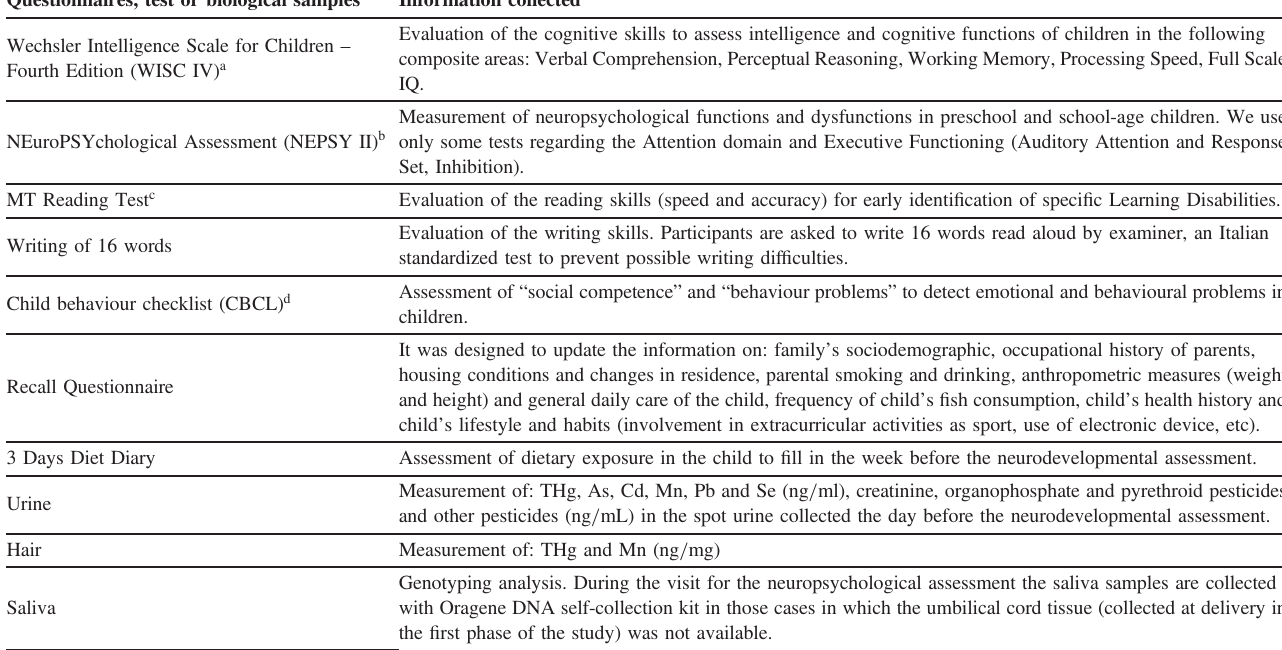
Table 3. Questionnaire, test, and biological samples collected at the follow-up of 7 years old of children Questionnaires, test or biological